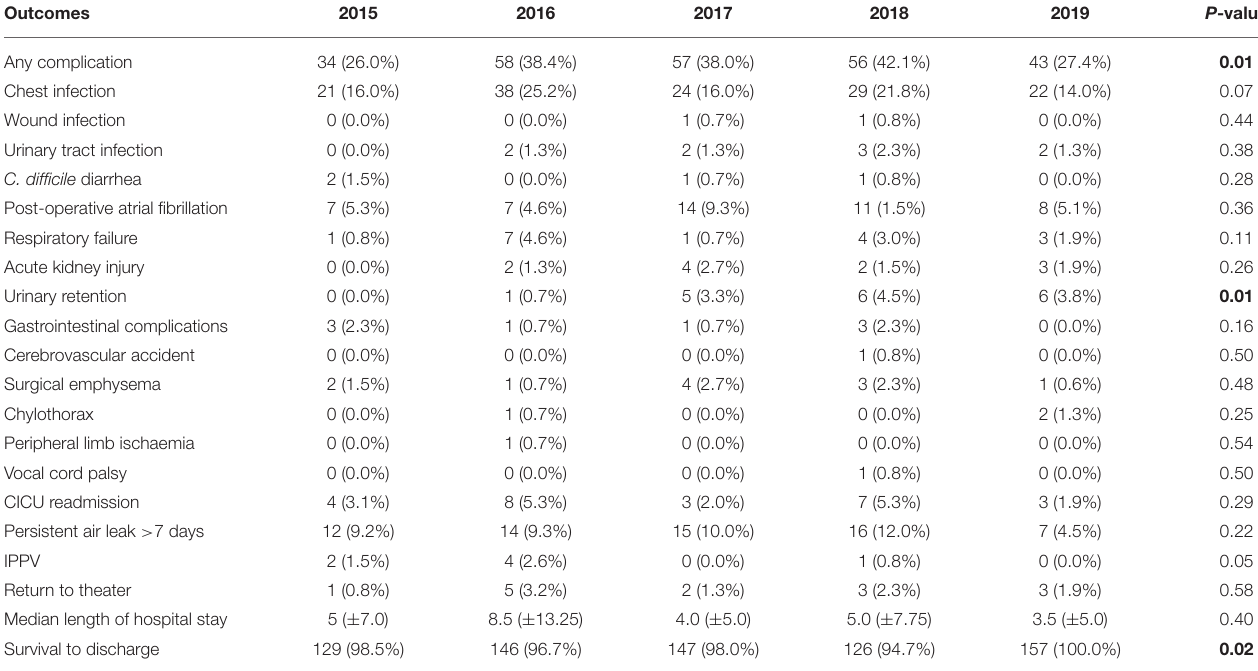
TABLE 6 | Post-operative complications over time.